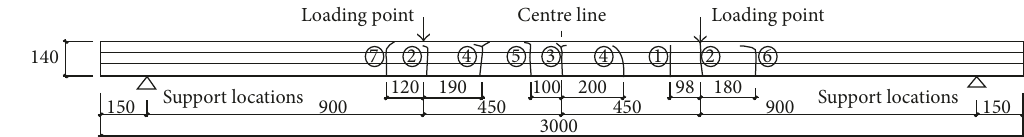
Figure 27: Cracking location